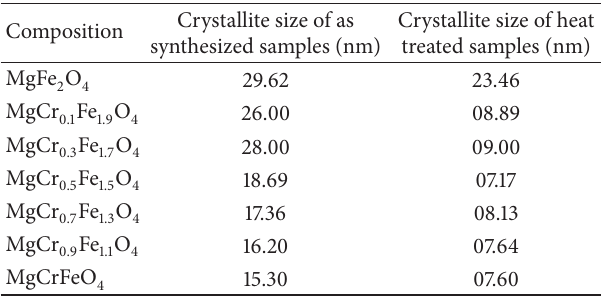
Table 1: Crystallite size of as synthesized and heat